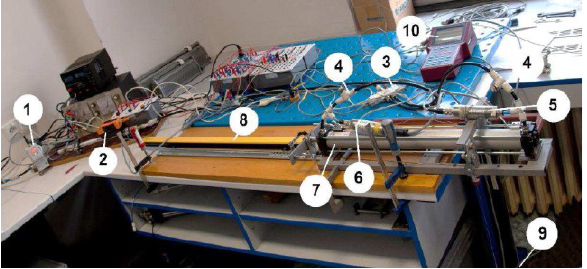
Fig. 5. Realization of measurement for reference measurement 1 – reduction valve, 2 – flow meter, 3 –directional control valve, 4 – throttle and check valve, 5 – pressure 𝑝 6 –, pressure 𝑝 sensor 7 – pneumatic cylinder (linear motor), 2 8 – position sensor, 9 – mass load, 10 - measuring equipment M5050